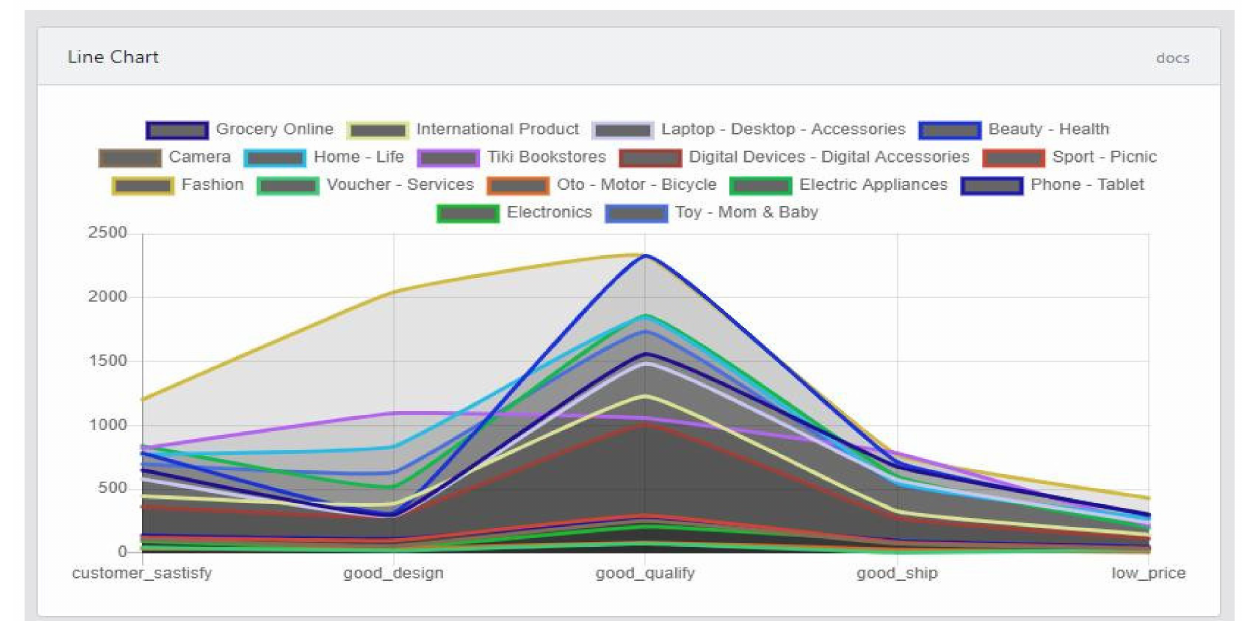
Figure 13. Sentiment results of product